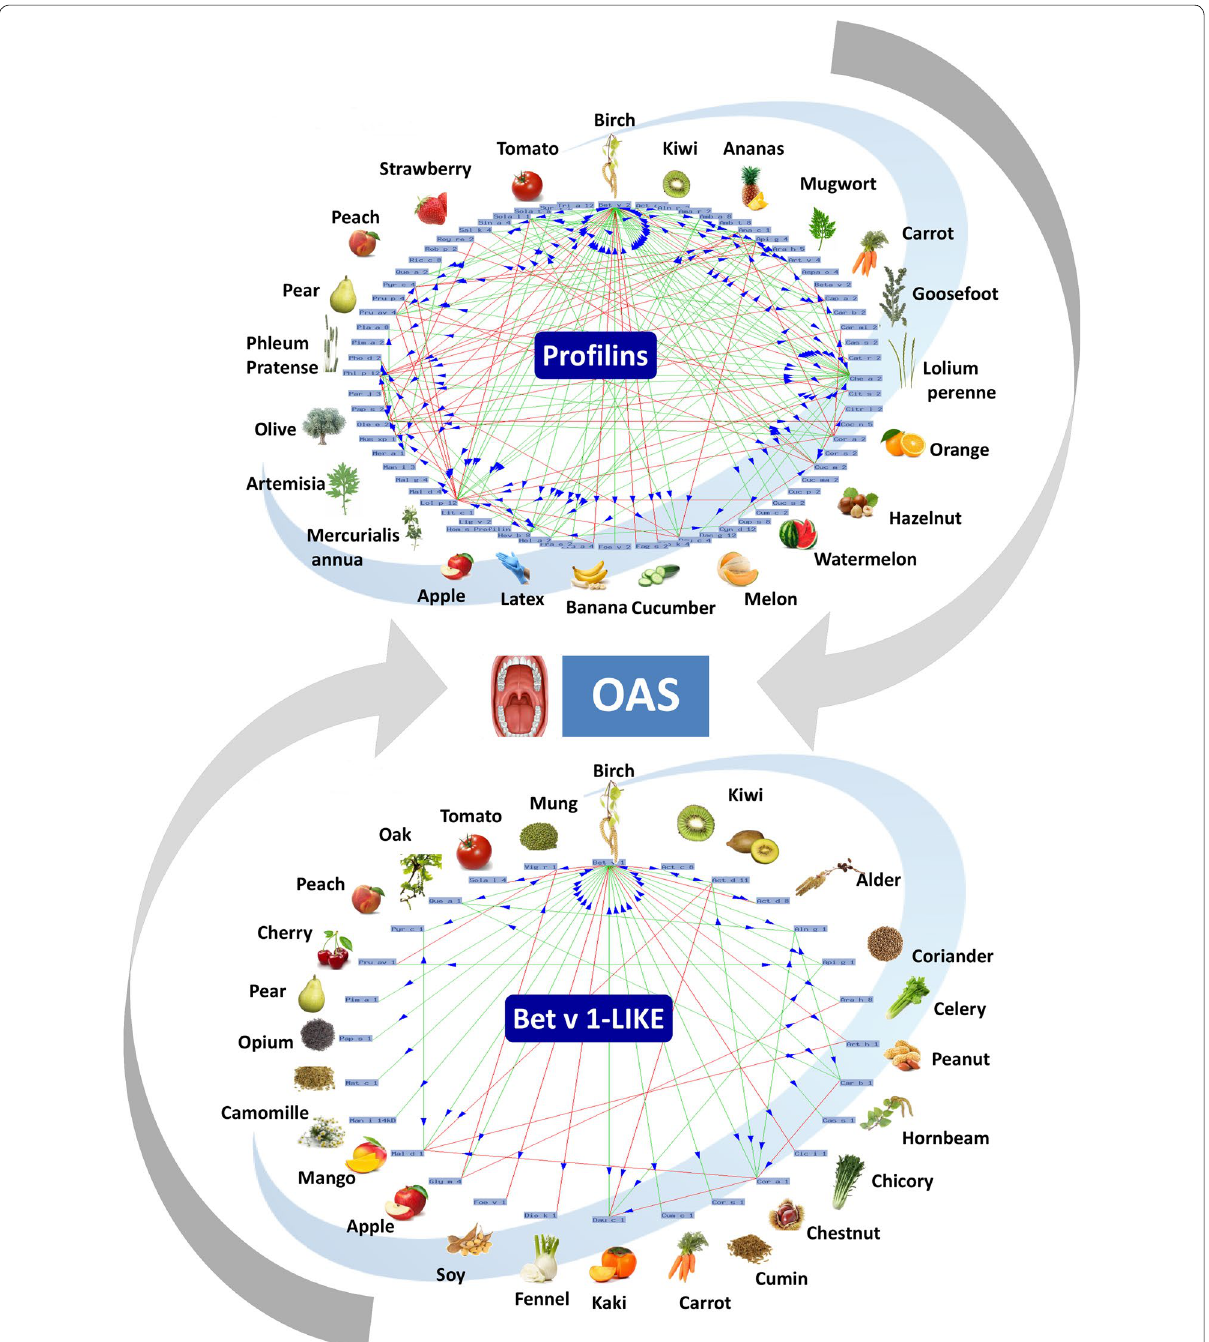
Fig. 3 Schematic representation of cross-reactivity occurring between profilins (upper O-ring) and between Bet v 1-related allergenic proteins (lower O-ring) contained in pollens and plant foods. Red and green lines connecting allergy sources indicate single and double cross-reaction relationships, respectively. Arrowheads indicate the direction of data collection. The two pictures were generated on January 2020 by the Allergome software which uses information contained in the own database [53] (https ://www.aller